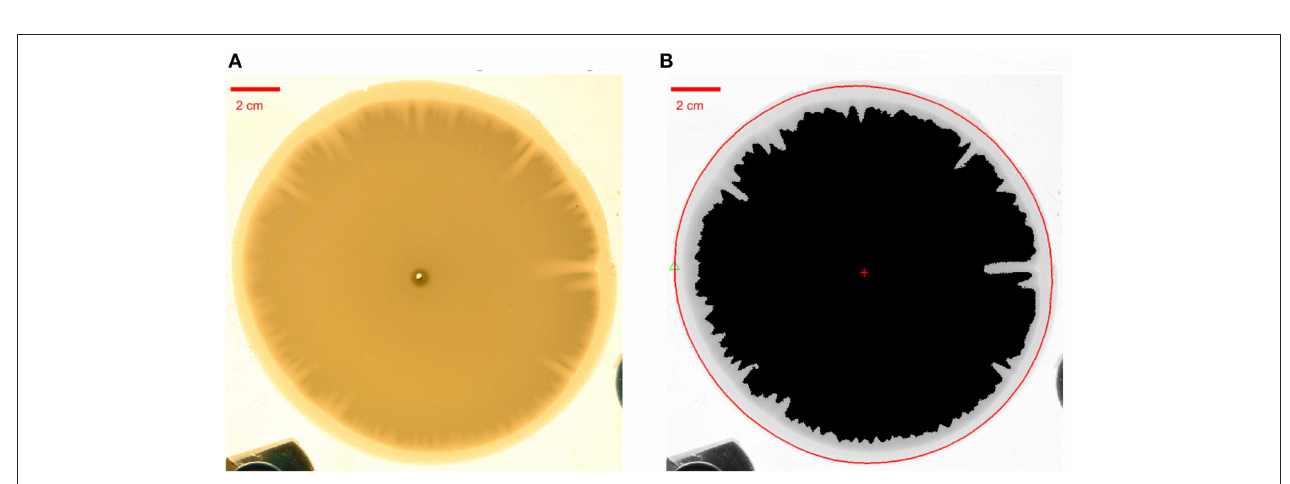
FIGURE 7 | Estimation of the local dissolved part. (A) An experimental photo to be processed. (B) The red circular line acts as the reference curve, which represents the boundary of the initial plaster sample. The black part represents the undissolved part of the plaster sample. The red star marks the center of the plaster sample. We integrate the aperture variation values along a radial line from a point on the perimeter of the red circular line to the center.